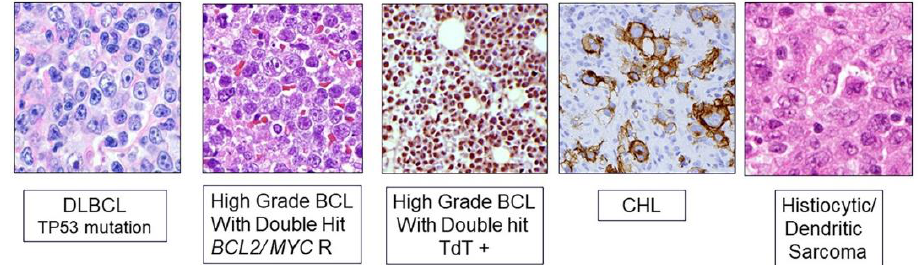
Figure 3. Transformed Follicular Lymphoma. All show clonal identity and retain the BCL2 rear- rangement.